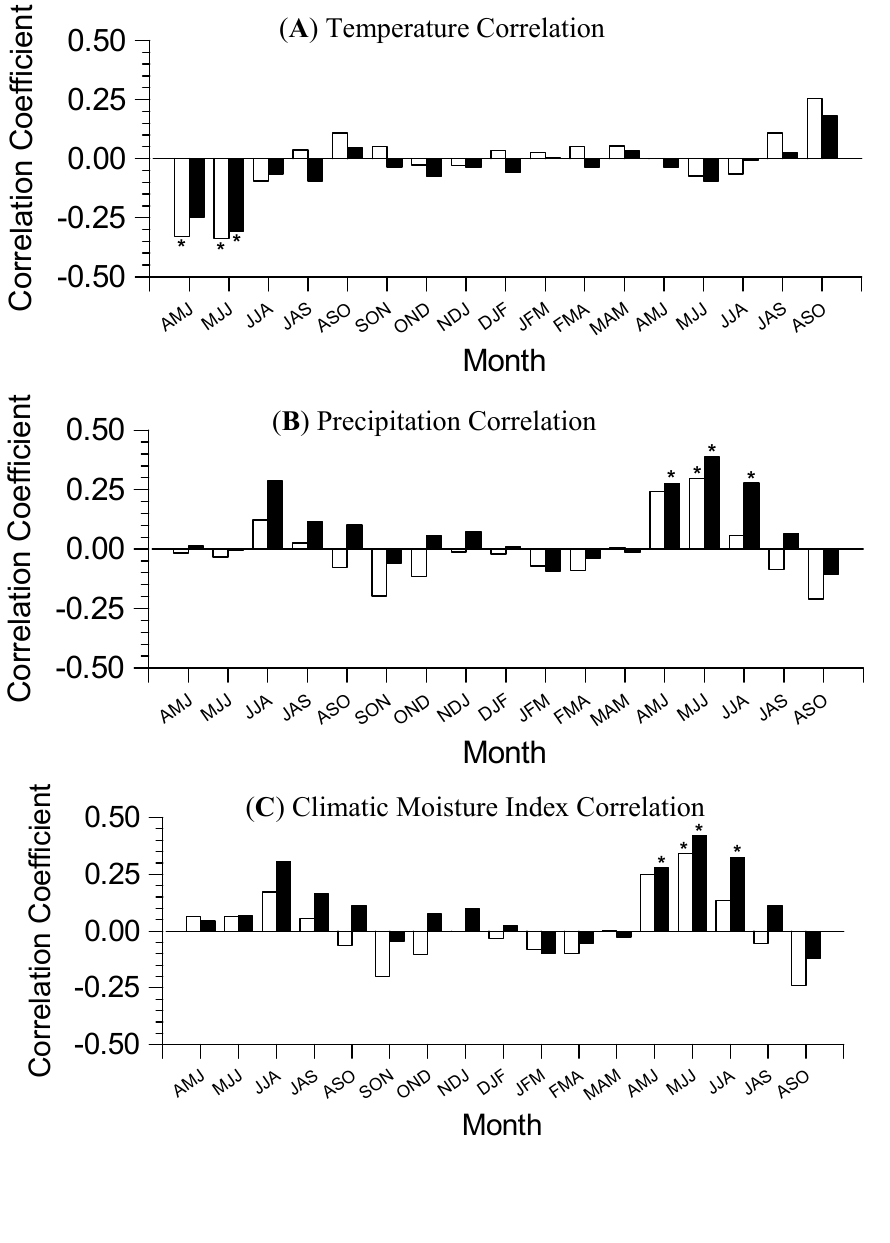
Figure 7. ( A ) Seasonal temperature correlation, ( B ) seasonal precipitation correlation and ( C ) seasonal climatic moisture index correlation to radial growth of red pine in the Huron National Forest, Michigan, based on climate from 1965 to 2010. Analysis begins in April of the previous year until October of the current year. An asterisk denotes a significant correlation coefficient that is outside the 95% range of coefficients derived from 1000 bootstrapped iterations. LD (open bars) represents low density plots and HD (closed bars) represents high density